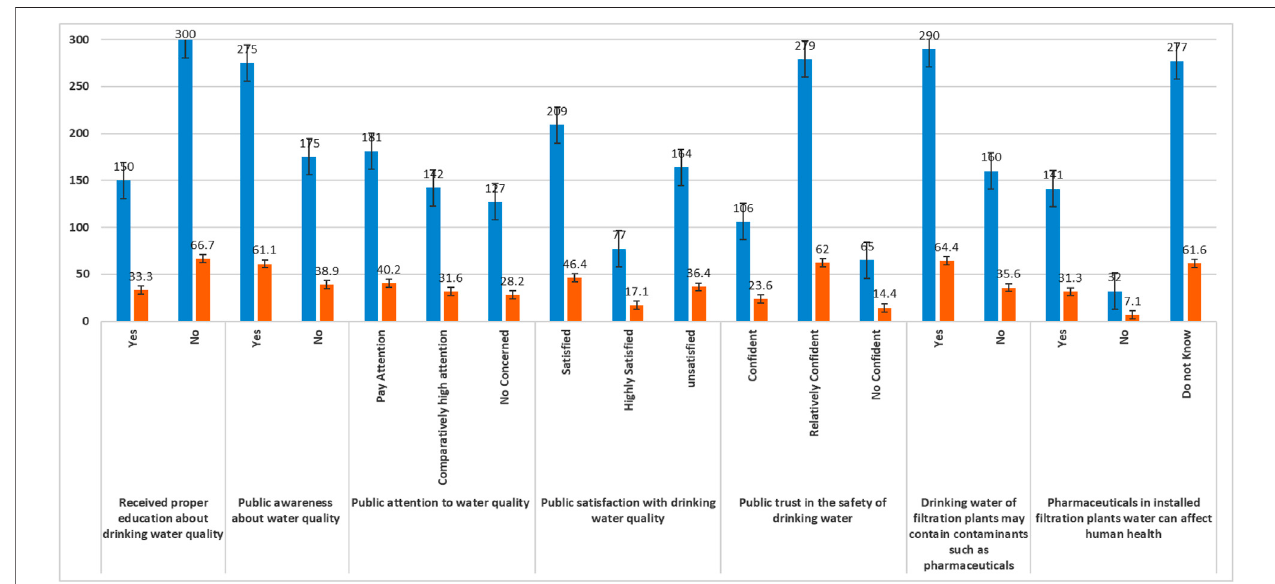
FIGURE 2 | Knowledge score about water quality of fi ltration plants.